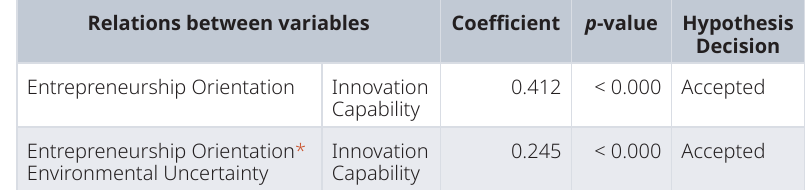
Table 3. Hypothesis testing